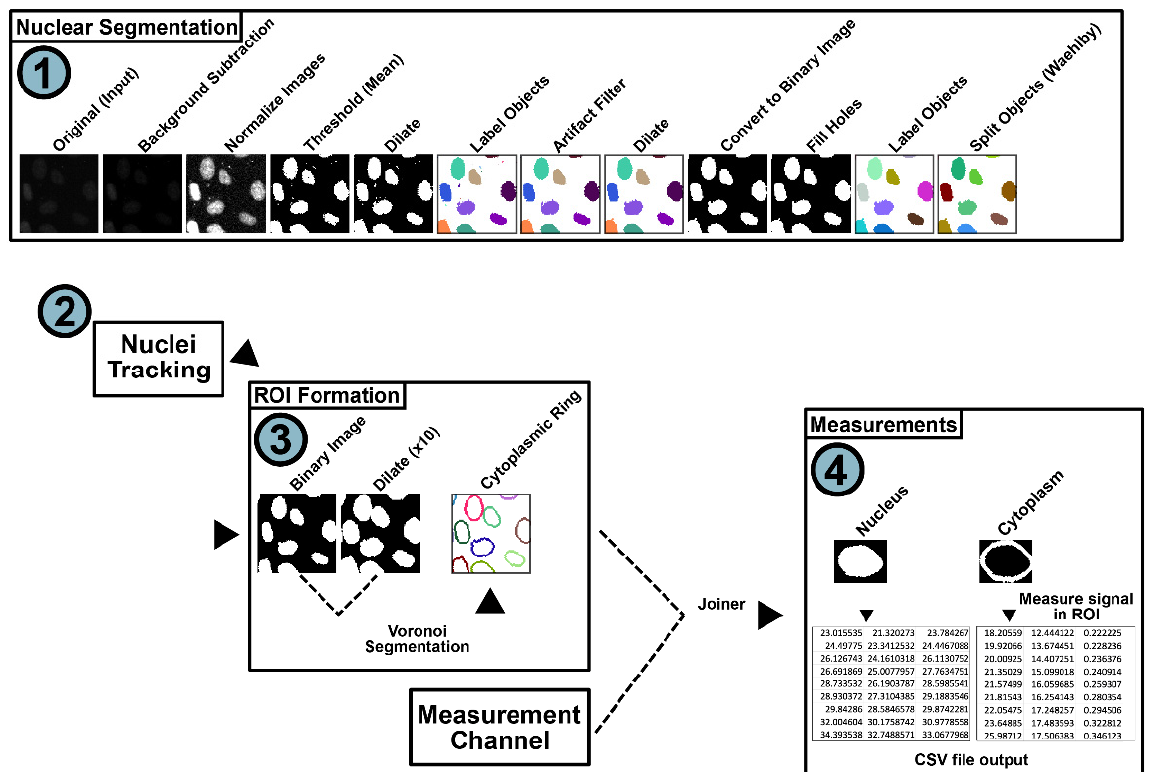
Figure 4. NR-SAT single-cell segmentation and tracking scheme. (Phase 1) The input nuclear channel is illumination-corrected using background subtraction, followed by local contrast enhancement. The resulting images then undergo thresholding (Mean method) and are dilated and then labeled. An object filter is applied to remove threshold artifacts prior to converting the images into binary images and filling holes. Finally, the data is passed to the Wählby Cell Clump Splitter, which separates nuclei that are in proximity to one another. (Phase 2) These data are then passed to the nuclei tracking nodes where the ImageJ plugin TrackMate is implemented to track each cell, accounting for splitting and merging events. (Phase 3) After the nuclei are tracked, the nuclear mask is duplicated and dilated (number of dilations is user-defined and applied to all images in the same manner, 10× in this example) to generate two masks, where the newly dilated mask is larger than the original source mask. These two masks (the newly larger dilated mask and the smaller original mask) are then segmented via the Voronoi segmentation node, generating cytoplasmic rings that are approximately a fixed pixel-width. (Phase 4) Finally these cytoplasmic rings, along with the nuclear masks, are applied to the measurement channel(s) and written to a CSV output file.